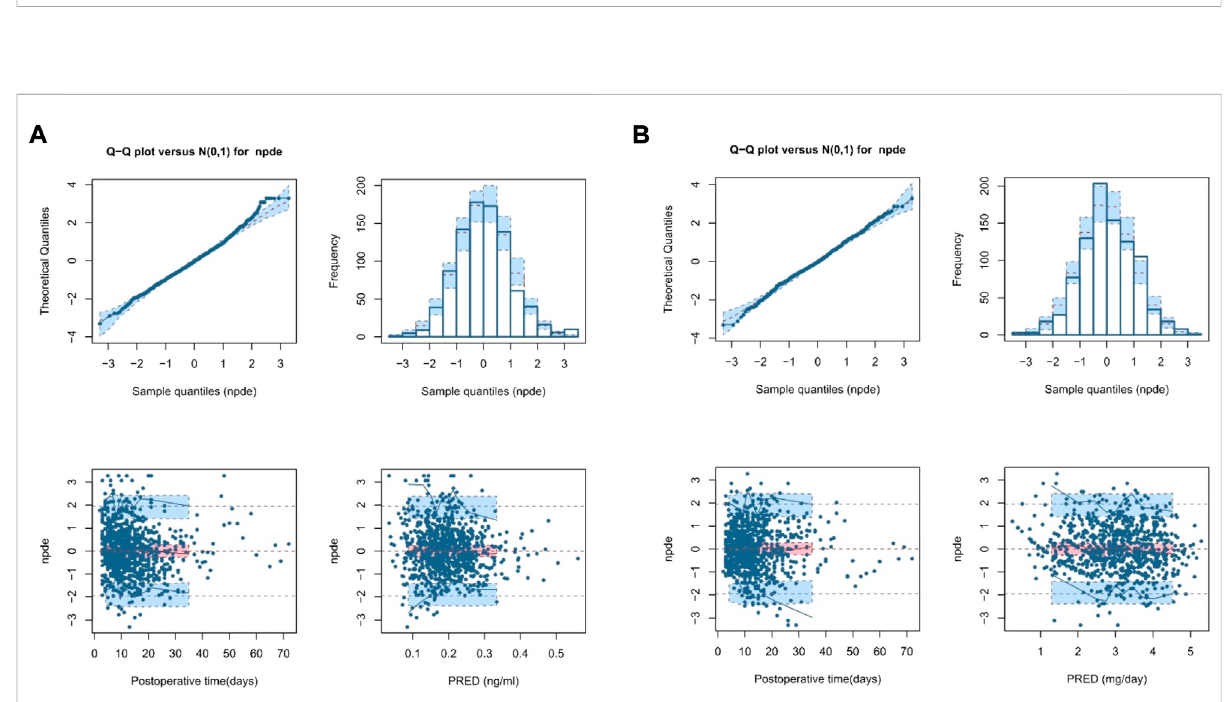
FIGURE 3 Normalizedpredictiondistributionerror(NPDE)plotofthetheory-based fi nalmodelplot (A) andMM fi nalmodelplot (B) .Theplotsarequantile- quantile plot of the distribution of NPDE against the theoretical distribution (semitransparent blue fi elds) (top left), histogram of the distribution of NPDEagainstthetheoreticaldistribution(semitransparentblue fi elds)(topright),scatter plotofNPDEvs.postoperativetime (days)(bottomleft),and scatter plot of NPDE vs. population predictions (bottom right). In the scatter plots, the red solid lines represent the median NPDE of the observations,andsemitransparentred fi eldsrepresent thesimulation-based 95%con fi denceintervals(CIs) for themedian.Bluesolidlinesrepresent the NPDE of the observed 5th and 95th percentiles, and semitransparent blue fi elds represent the simulation-based 95% CIs for the corresponding predicted percentiles from the model. The blue dots represent the NPDE of the